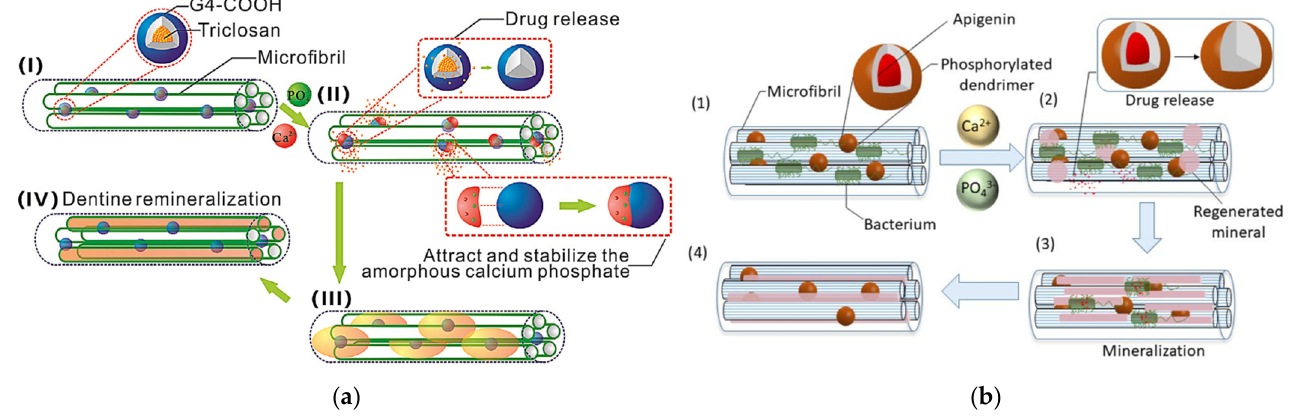
Figure 24. ( a ) Schematic illustration of the sustained release of encapsulated triclosan from the formulation and the simultaneous mineralization induced by G4 PAMAM-COOH. (I) The triclosan-loaded G4 PAMAM-COOH is adsorbed on the dentine microfibrils. (II) Encapsulated triclosan is released during the incubation in an artificial saliva solution. Meanwhile, the anionic carboxylic groups of G4 PAMAM-COOH attract and stabilize the amorphous calcium phosphate (ACP) in an artificial saliva solution. (III) The mineralized fibrils could emerge due to the template role of dendrimers. (IV) The mineralized fibrils become larger, making ACP arranged in an ordered manner and resulting in HA crystallization Reproduced with permission from [239]. Copyright: Elsevier B.V. ( b ) Phosphoryl-terminated PAMAM dendrimers loaded with apigenin induce dentine tubules